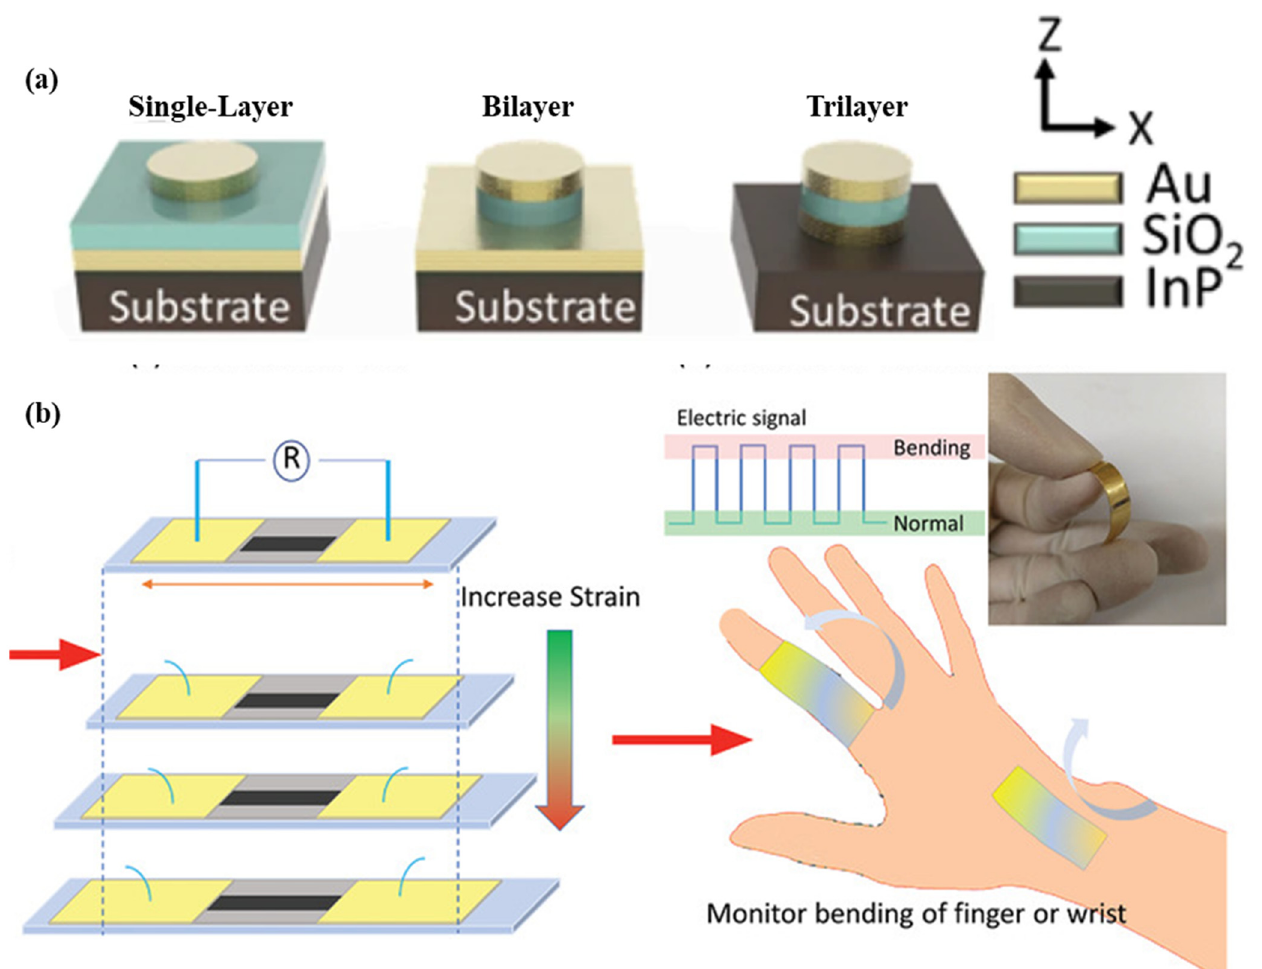
Figure 6. Schematic of the ( a ) flexible MIM-disk-based LSPR cancer sensor. Reprinted with permission from Scientific reports, Copyright 2018, Nature Publishing Group [59]; ( b ) graphene oxide and AuNPs based wearable LSPR strain sensor, Reprinted with permission from Advanced Materials Technologies, Copyright 2021, Wiley [60].